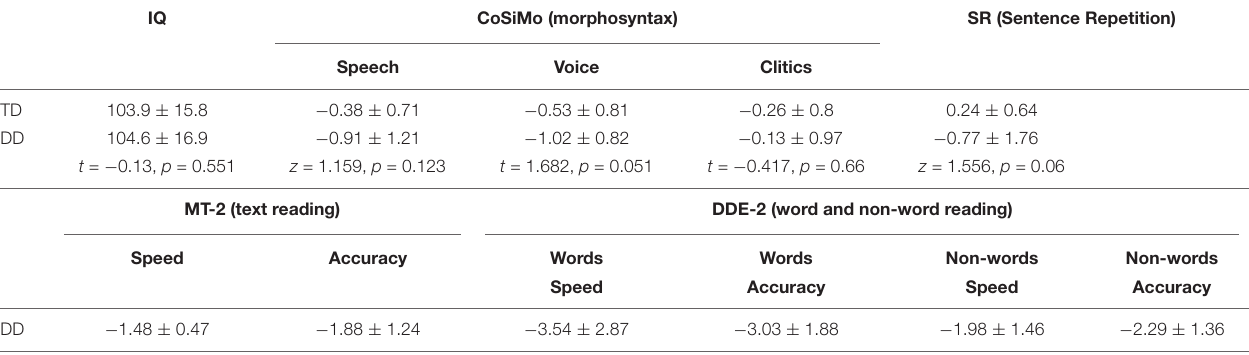
TABLE 1 | Mean ( ± SD) standardized scores of the TD and DD groups. IQ CoSiMo (morphosyntax) SR (Sentence